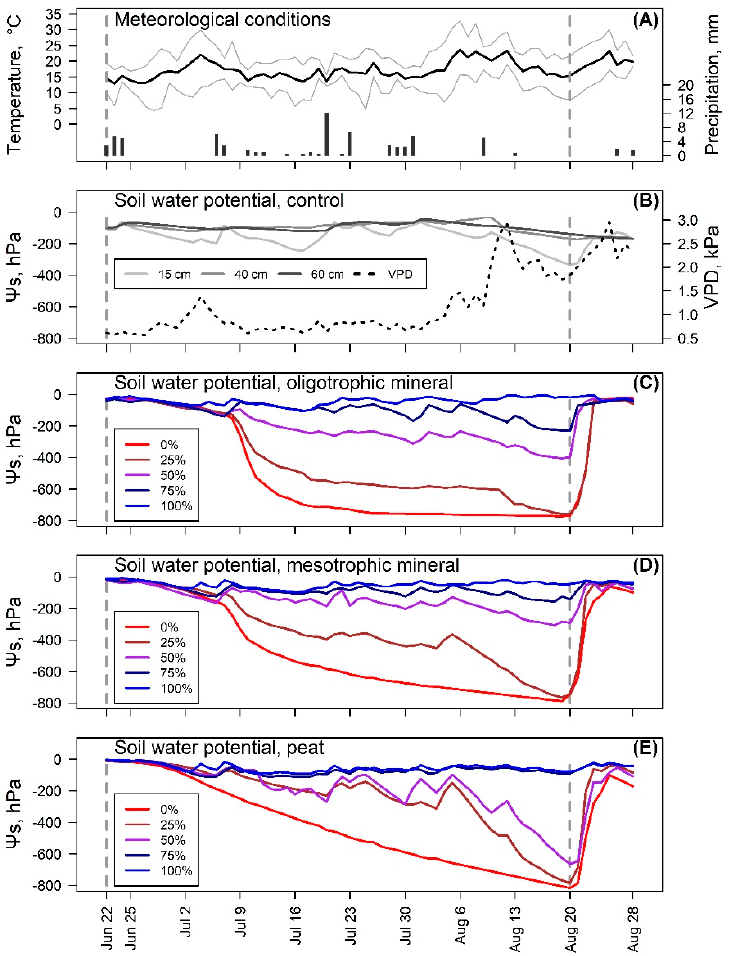
Figure 1. Meteorological and soil moisture conditions during the experimental period. In ( A ), daily mean (bold black line), minimum and maximum (grey lines) temperature and precipitation (bars) are shown. In ( B ), atmospheric vapour pressure deficit (dotted line) and soil water potential ( Ψ s) at three soil depths is shown. Panels ( C – E ) show the soil water potential in the shelter pots filled with oligotrophic, mesotrophic, and peat forest soil according to the irrigation intensity. The vertical dotted lines denote the initiation and termination of precipitation manipulation.